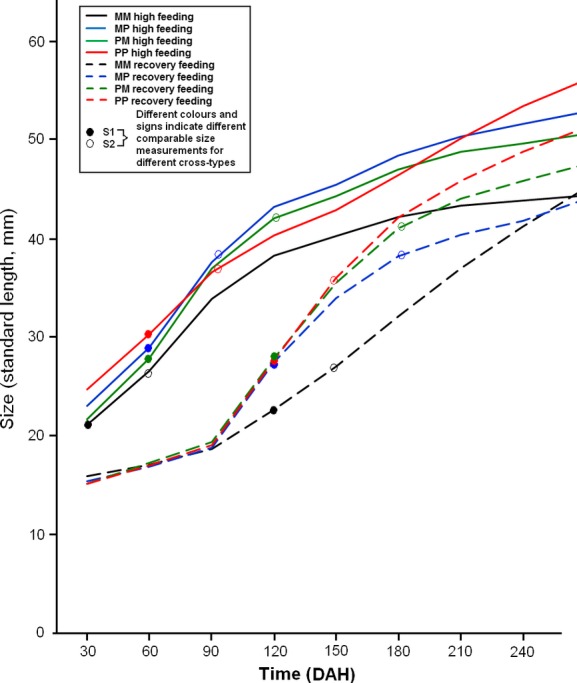
Definition of the comparable size points (S1–S2) in high and recovery feeding treatments which were used to compare specific growth rates (SGR) in the “asynchronous” approach. Note that exact matching of comparable points was not always possible because of fixed time intervals used for measurements.